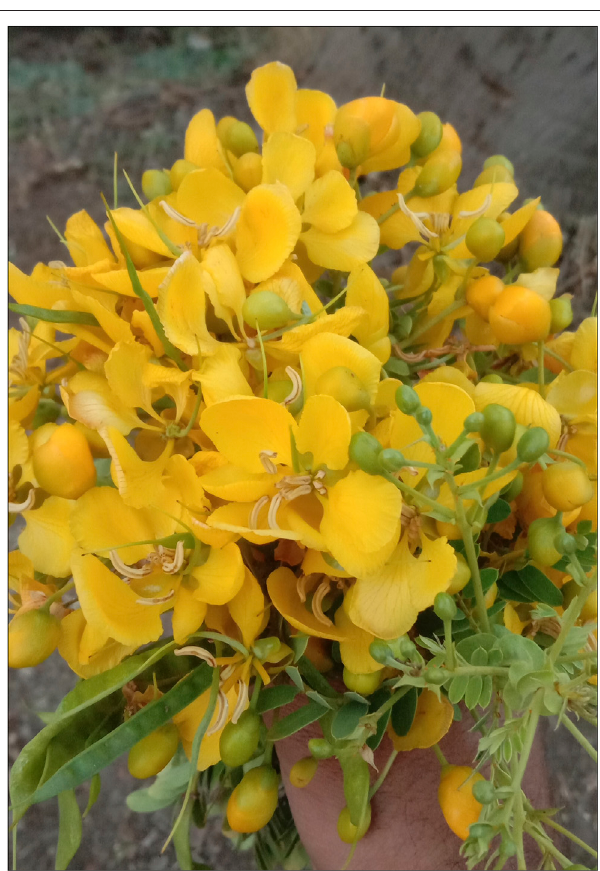
FIGURE 1 | Flower & Leaves of Senna auriculata (L.)